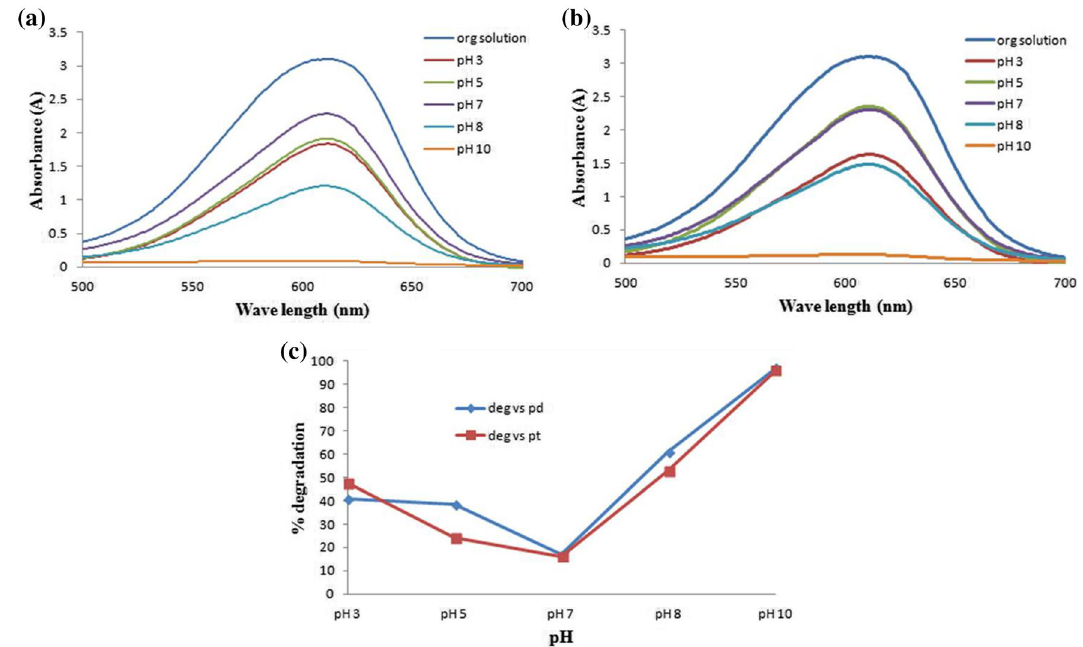
Fig. 5 a UV–VIS absorbance spectra of indigo disulfonate degraded at different pH mediums by Pd/ZrO degradation at different pH